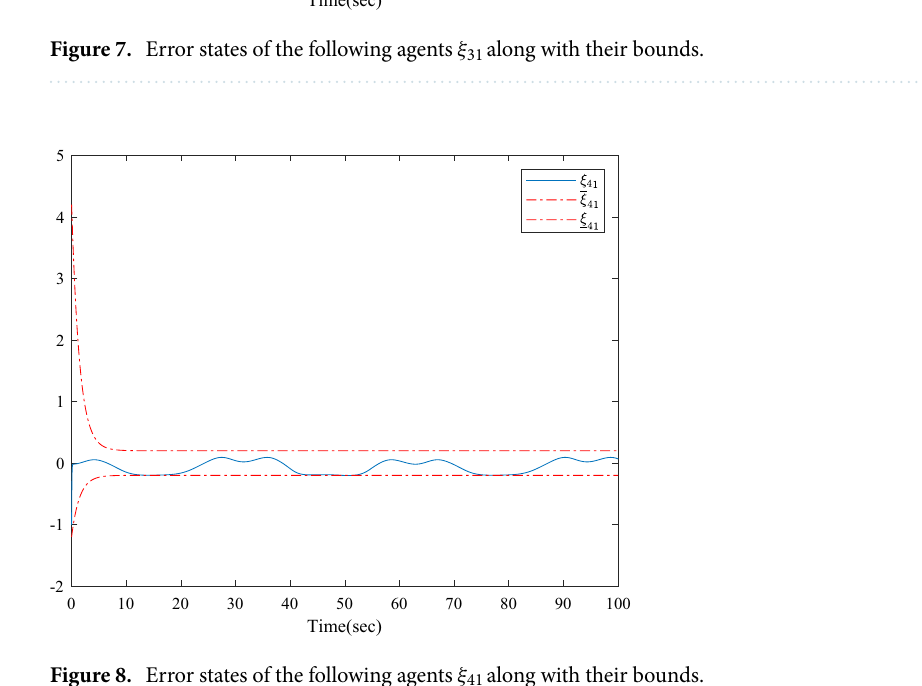
Figure 8. Error states of the following agents ξ 41 along with their